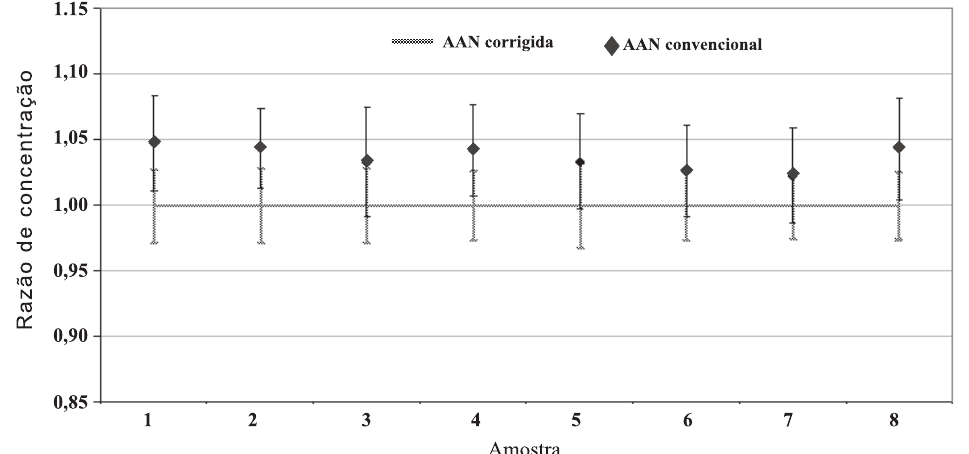
Figura 4. mn: comparação entre os valores experimentais obtidos no método aan corrigida e os valores da aan convencional de amostras de solo do Quadrilátero Ferrífero. as barras verticais são as